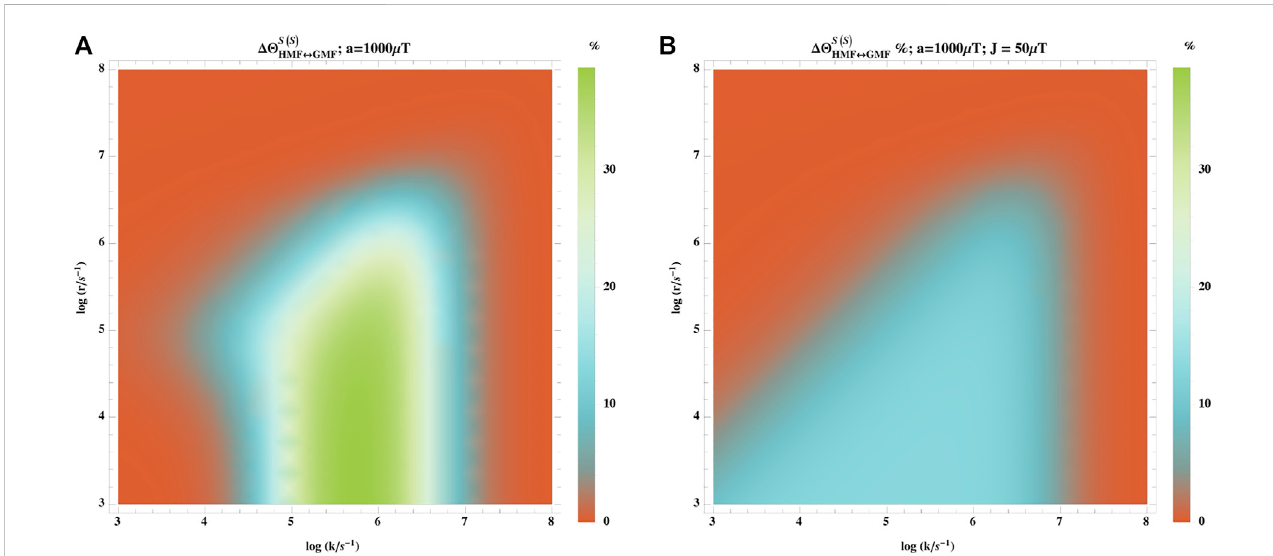
FIGURE 7 Effectofexchangeinteractiononthehypomagnetic fi eldeffects.Thehypomagnetic fi eldeffectisbasedonthesingletyieldratiowithinitialsingletstates without (A) andwith (B) theexchangeinteraction. Theexchangeinteractioncouplingis − 50 μ T.Inthismodel,oneoftheradicalshasnohyper fi neinteraction, and the other is coupled to an isotropic hyper fi ne coupling constant of a eiso = 1,000 μ T. The exchange interaction signi fi cantly attenuates the hypomagnetic fi eld effects.